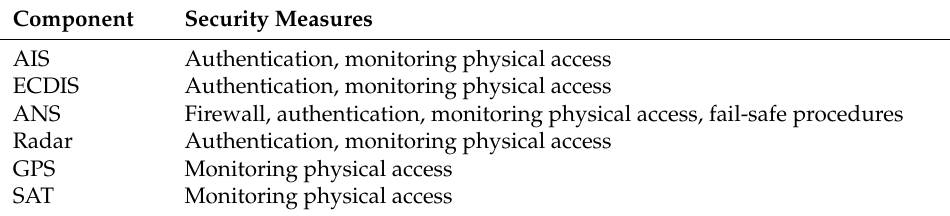
Table 1. Security measures of the autonomous ship’s components.